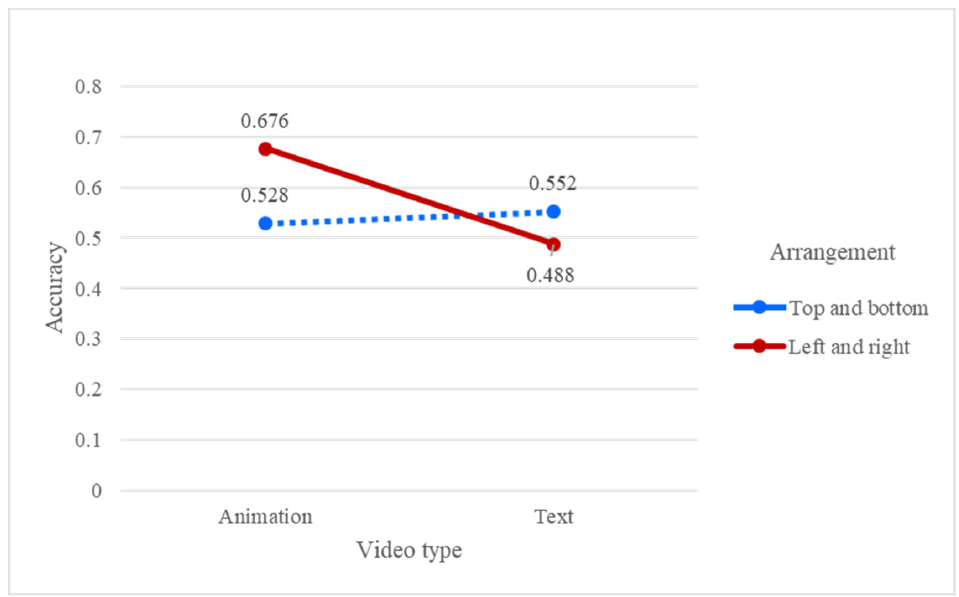
Figure 4. The interaction between film type and arrangement for accuracy. The results also indicated that the background was a significant factor. The accuracy of the video without a background (M = 0.604) was significantly lower than that in the video with a background (M = 0.518). Huang and Pashler [9] indicated that the difficulty of a visual search affected efficiency. Marlen et al. [10] also found that high visual com- plexity and high verbal ambiguity resulted in a low accuracy and slow response time on visual search tasks. In this study, the white color was set for the without background con- text and scenery was set for the with background context. Compared to the monochro- matic color, scenery with multiple colors could produce more visual stimuli and result in a low accuracy.